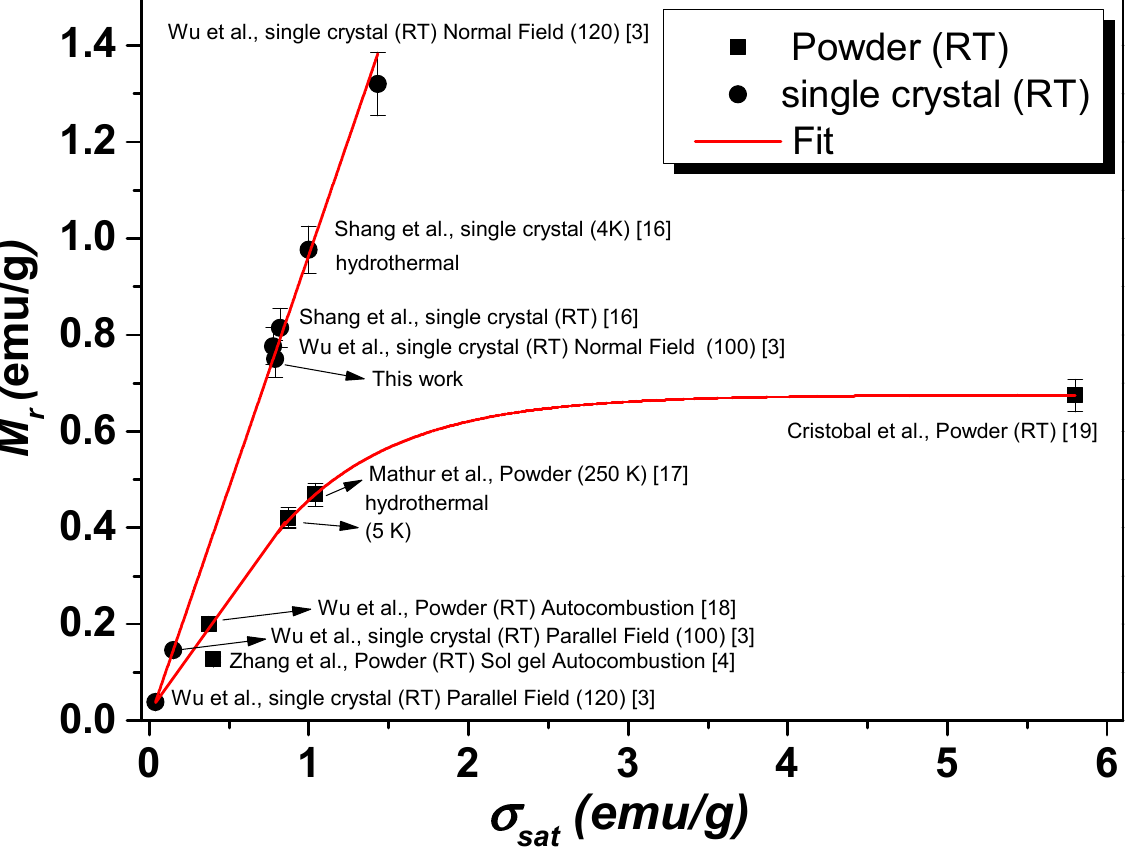
Figure 7. M r vs. σ sat relation built from data recorded at RT and reported in the literature for similar compounds. Comparison between powder and single crystal YFe x Cr 1 − x O 3 .